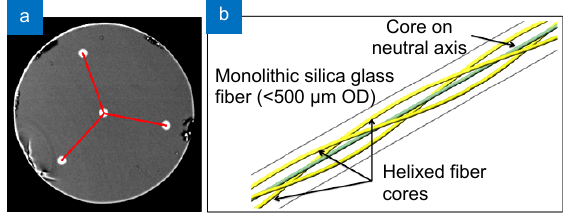
Fig. 6 | Illustration of shape sensing using helical multicore op- tical fiber. ( a ) Microscope view of the four - core sensing fiber, sensing triad in red. ( b ) Illustration of helical cores along length of fiber. Figure reproduced from ref. 40 , SPIE.